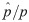
Sample means and 95% confidence intervals of 30 ratios of p^/p.For each combination of n = 10,000, 20,000, K = 80 and s/n = 1%, 3%, 5%, 30 WS networks were generated with a randomly chosen p ∈ [0.05, 0.2]. For each network, the value of p^ was calculated from Algorithm 1.